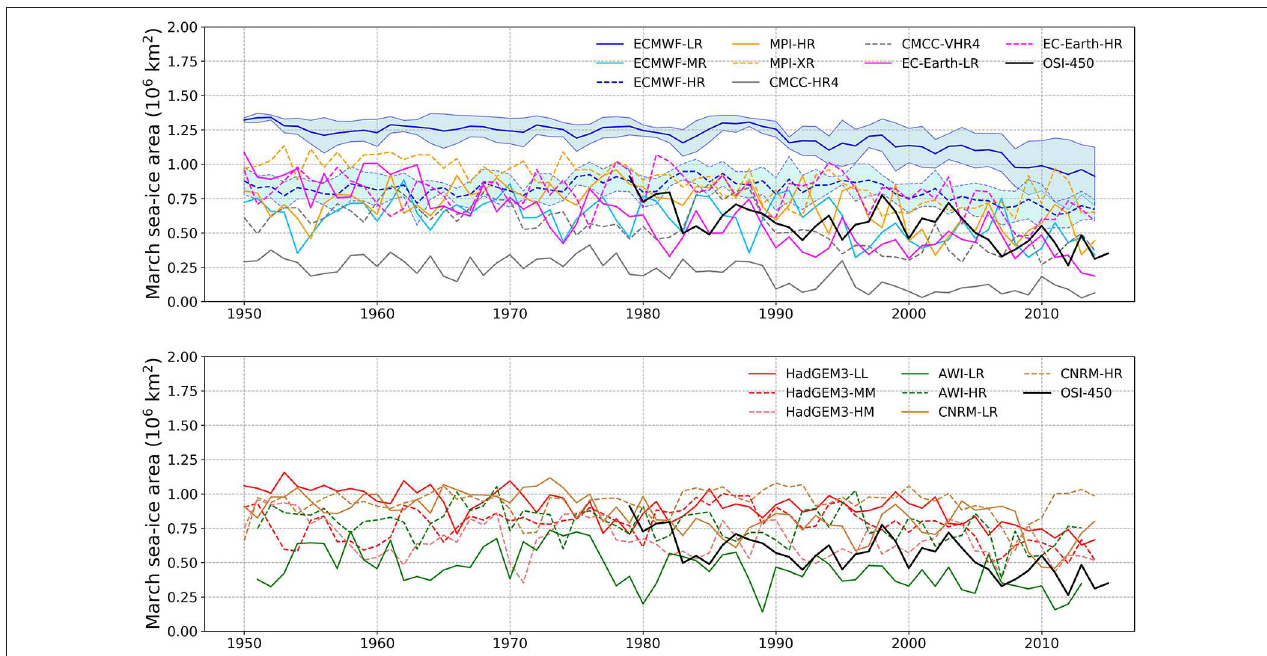
FIGURE 2 | Time series of Barents sea-ice area in March over 1950–2014 using HighResMIP hist-1950 model outputs (split in two different panels for readability) and OSI-450 observations. The blue shadings of ECMWF-LR and ECMWF-HR represent the ensemble standard deviation (six members for each).